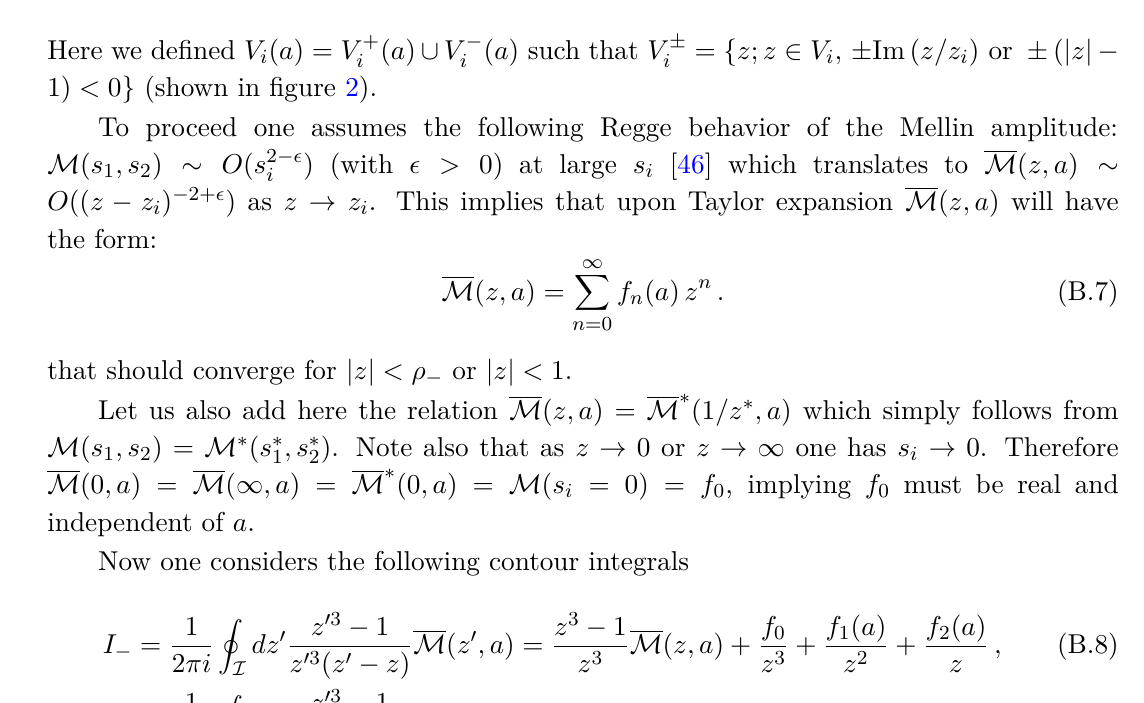
Figure 2 . A schematic picture of the physical cuts in z -plane. The colours indicate V 1 (red), V 2 (green) and V 3